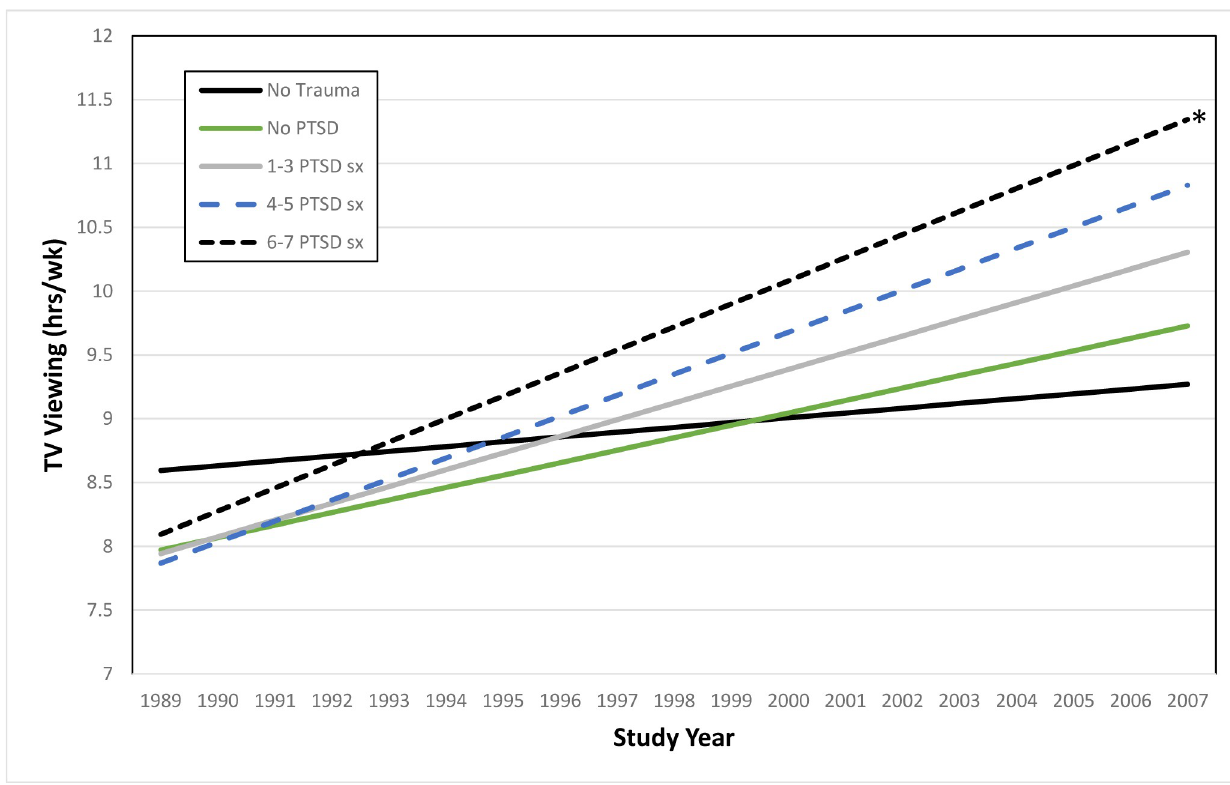
Fig 2. Age-adjusted predicted TV viewing trajectory over time by trauma/PTSD group among full sample (N = 50, 020) ( � Groups with no PTSD(with Trauma exposure), 1–3 PTSD symptoms, 4–5 PTSD symptoms and 6–7 PTSD symptoms were all significantly different from the no trauma group, p <